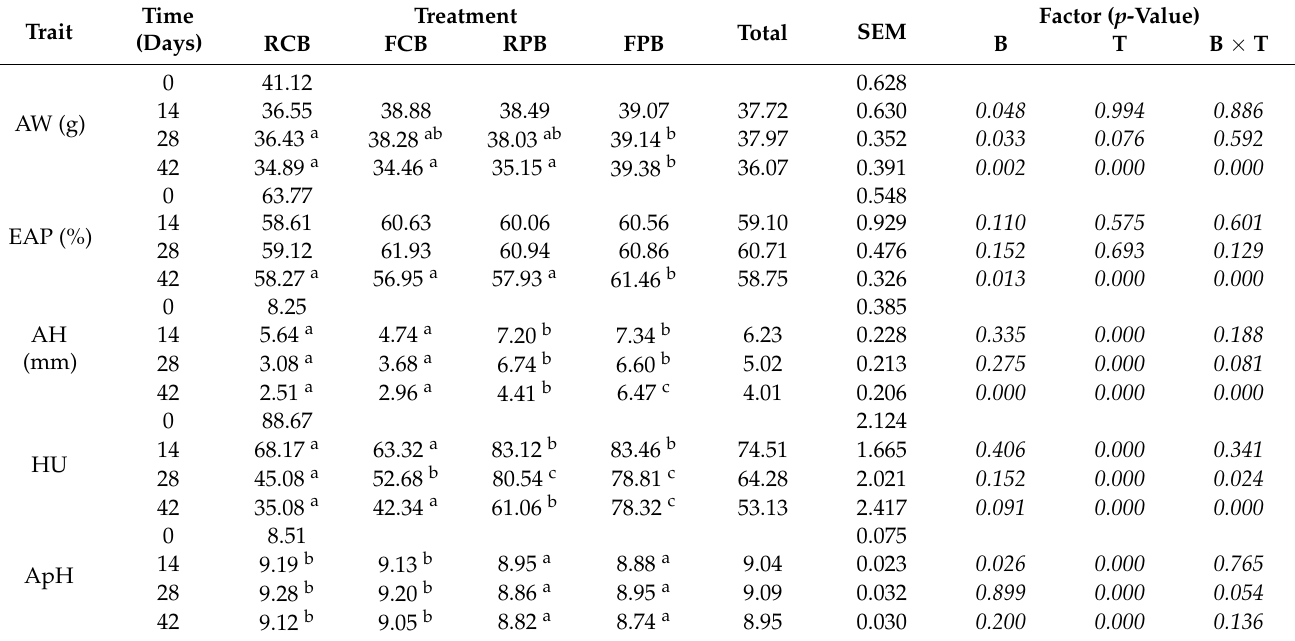
Table 3. Changes in albumen characteristics concerning packaging and storage temperature.